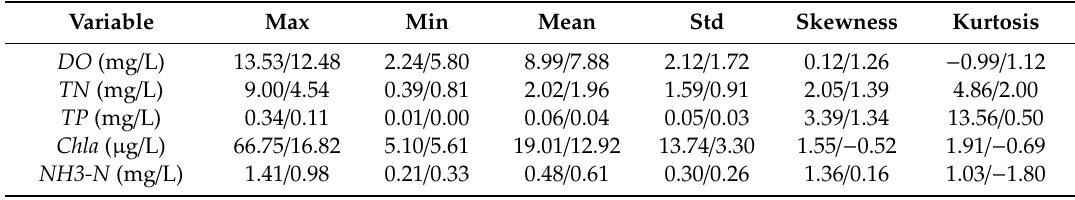
Table 2. Summary statistics of water quality variables. The data before “ / ” represent statistics in the period of B-IRSN, and the data after “ / ’ represent statistics in the period of A-IRSN.